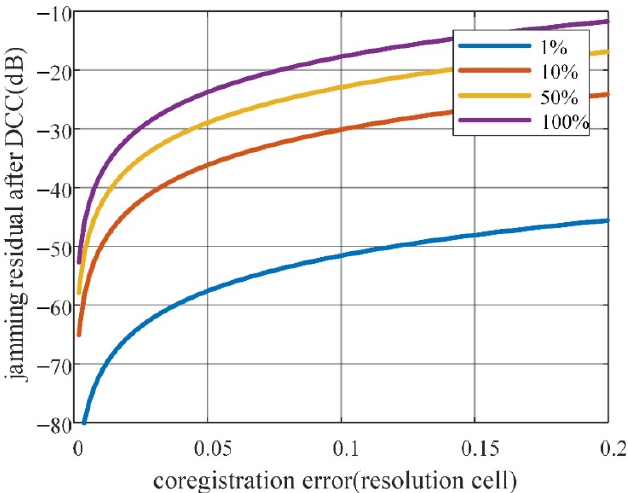
Figure 9. Jamming residual with co-registration error of different jamming bandwidth to signal bandwidth ratio.